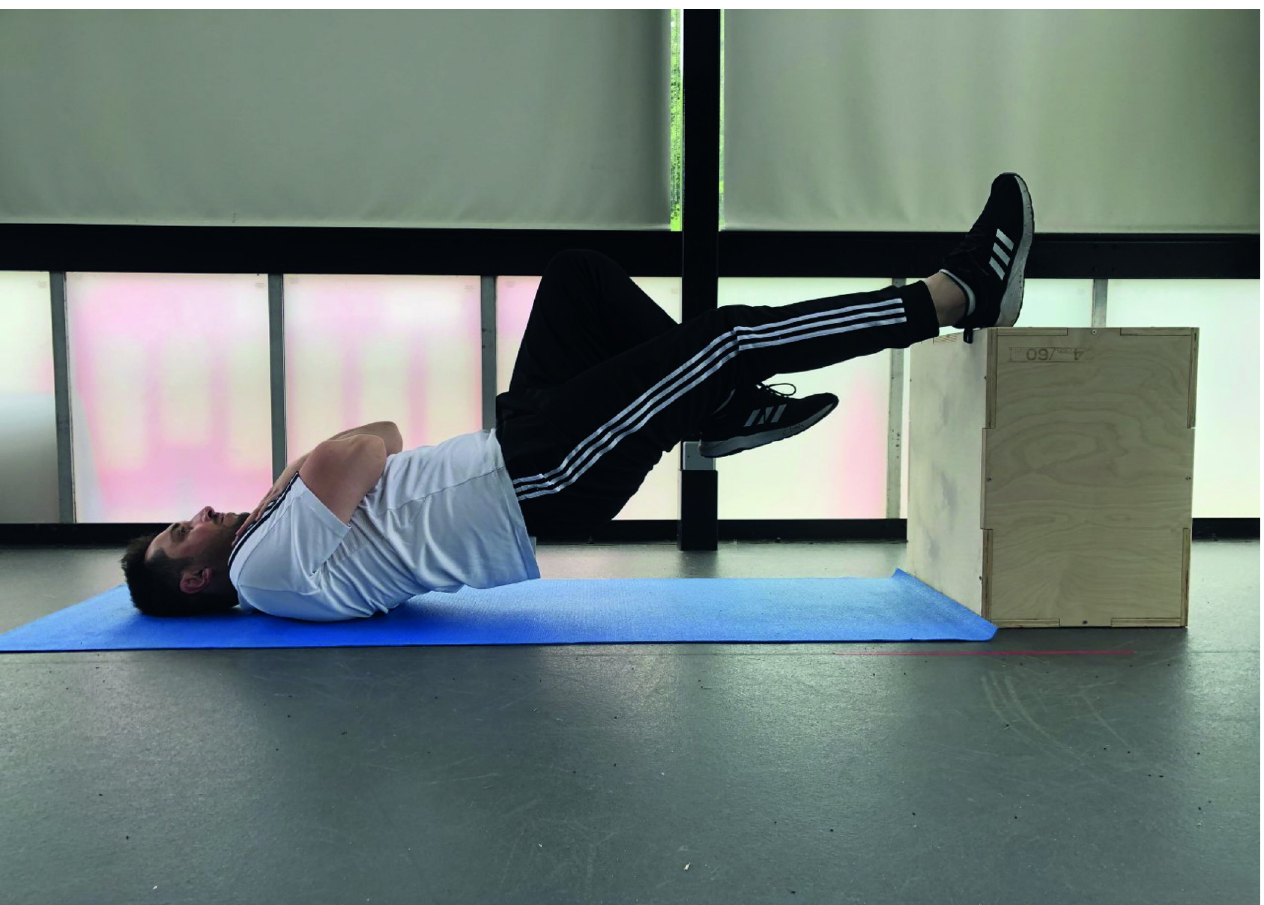
Fig 4. Single Leg Hamstring Bridge (SLHB) test. Participants were asked to perform movements by touching the ground by their bottom and reach 0˚ of hip extension by lifting their bottom respectively and without resting with the help of a 60-cm high box. The other leg was in a vertical position as inactive and stationary to eliminate any momentums that might be provided by swinging the leg. Participants were advised to aim to perform as much as they could repeat the same movement until failure. The individual pictured in Fig 4 has provided written informed consent (as outlined in PLOS consent form) to publish their image alongside the